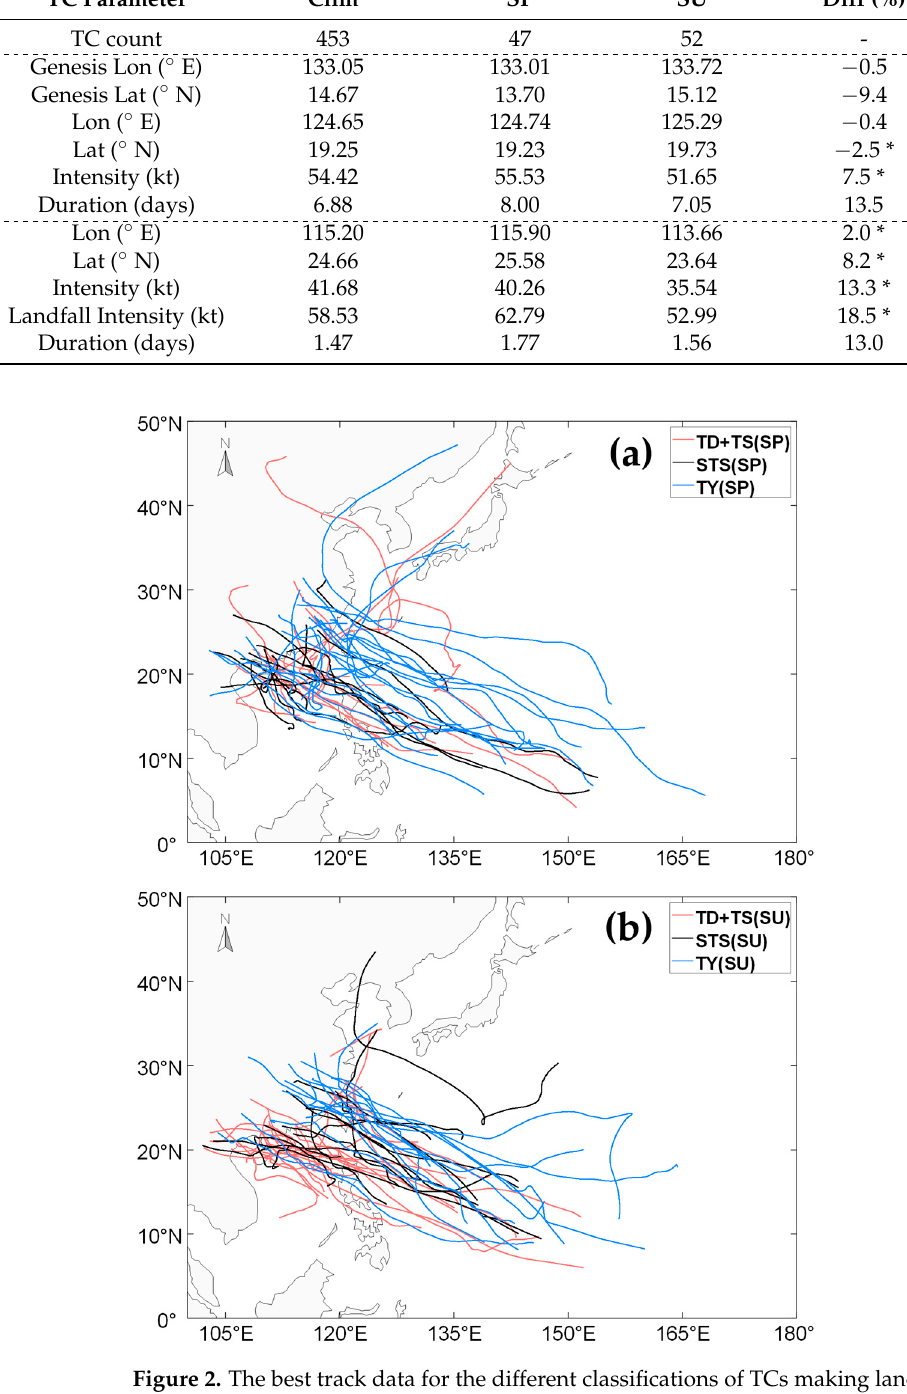
Figure 2. The best track data for the di ff erent classi fi cations of TCs making landfall in China during SP ( a ) and SU ( b ) El Niño years. SP ( a ) and SU ( b ) El Niño